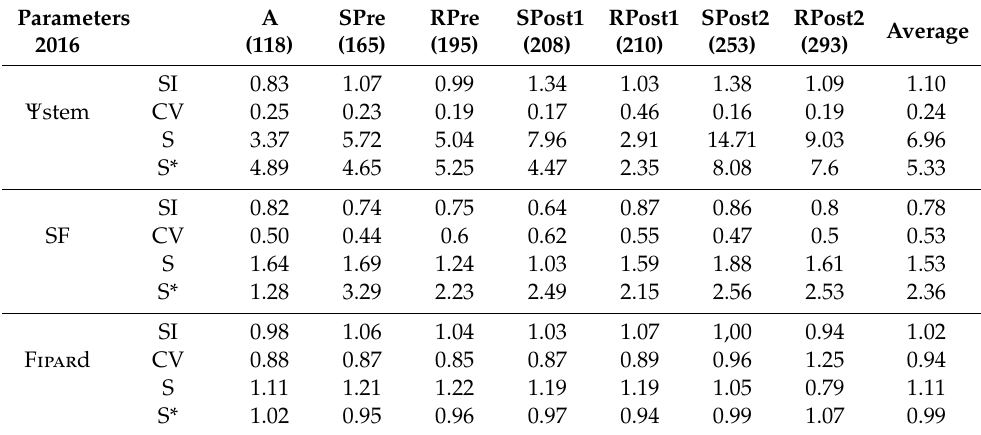
Table 4. Mean values of each parameter in the CON and D treatments, signal intensity, coe ffi cient of variation and sensitivity determined according to the traditional (S) and corrected (S*) method in